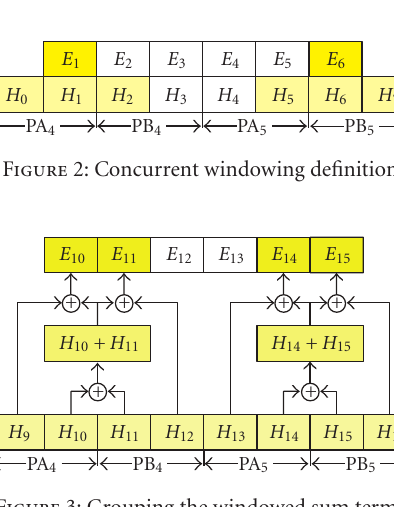
Figure 3: Grouping the windowed sum terms. Table 1: Number of clock cycles per